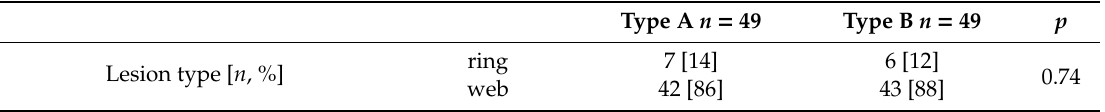
Table 2. Comparison of organized thrombi structure for type A and type B mechanisms of balloon pulmonary angioplasty